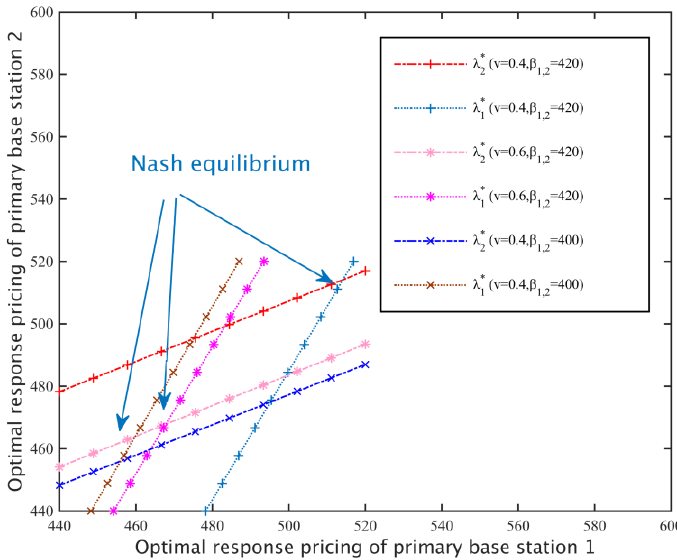
Figure 8. Optimal Response Function and Nash Equilibrium.